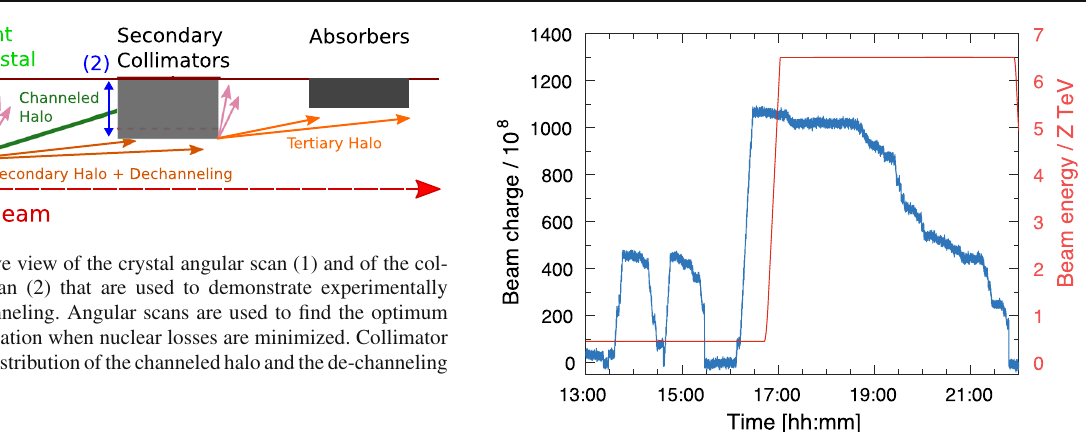
Fig. 3 Beam intensity in charges (blue, left axis) and energy (red, right axis) as a function of time during the beam measurements, performed on Nov. 29th,